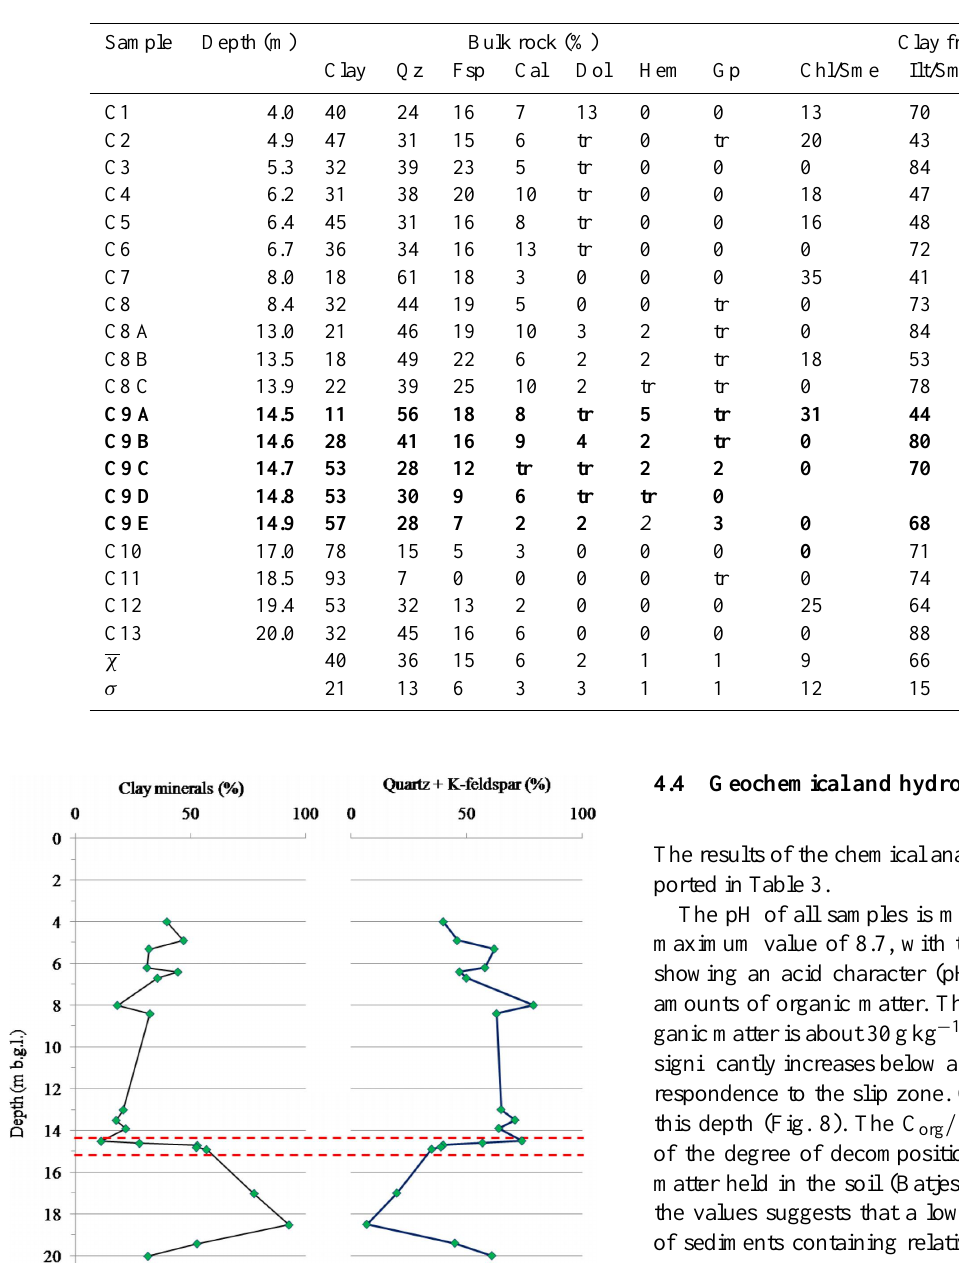
Table 2. Mineralogical composition of bulk rock and clay fraction (Qz = quartz; Fsp = feldspar; Cal = calcite; Dol = dolomite; Hem = hematite; Gp = gypsum; Chl/Sme = chlorite/smectite; Ilt/Sme = illite/smectite; Kln = kaolinite; Chl = chlorite; Ilt = illite). Slip zone samples are reported in bold.